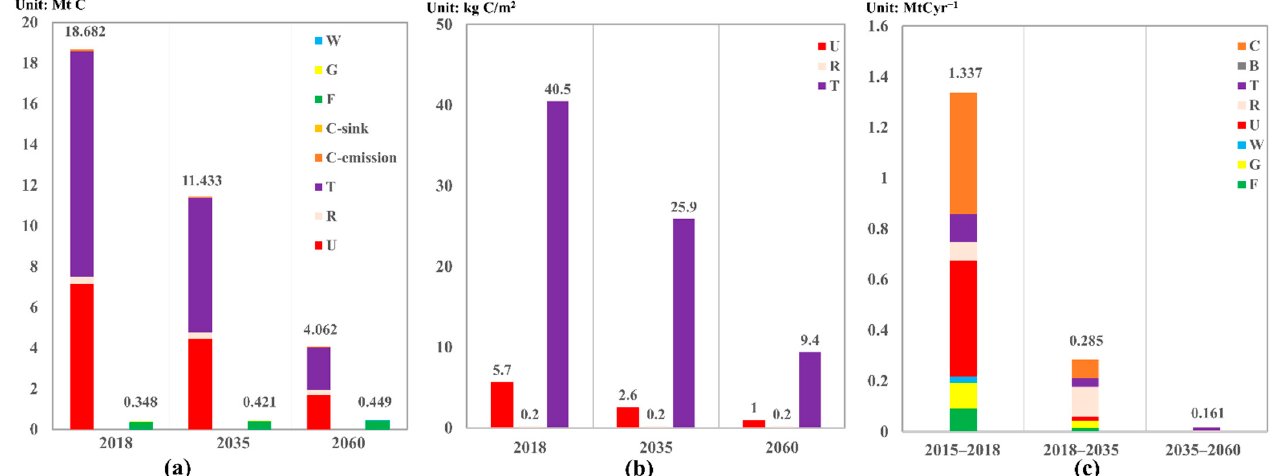
Figure 8. ( a ) Direct carbon emission and sinks in 2018, and predicted values in the 2035 and 2060 scenarios; ( b ) carbon metabolic intensity of the urban socioeconomic components in each year; ( c ) annual average integrated (direct plus indirect) flows from 2015 to 2018, from 2018 to 2035, and from 2035 to 2060. Note: F, forest; G, grassland; W, bodies of water; U, urban land; R, rural land; T, transportation and industrial land; B, bare land; C, cultivated land; C-emission, carbon emission from cultivated land; C-sink, carbon sinks produced by cultivated land.